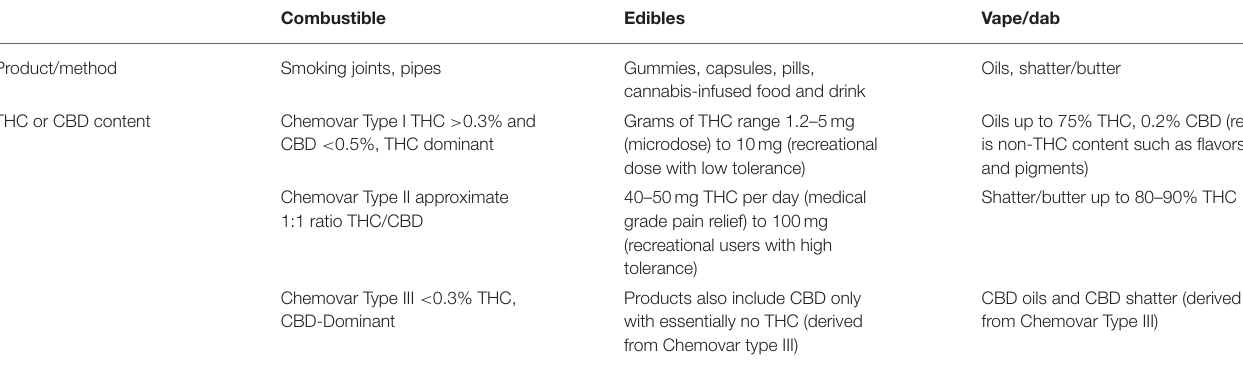
TABLE 1 | Examples of methods of cannabis